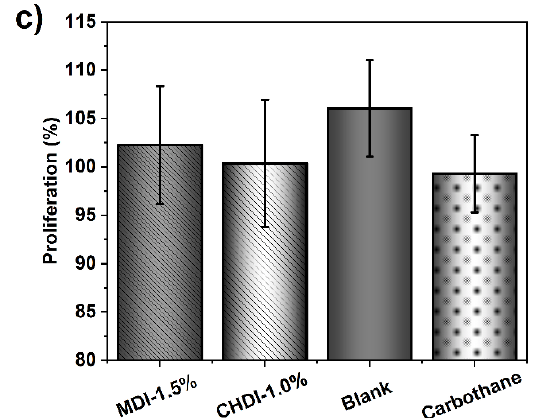
Figure 14. Viability of HaCaT cells after treatment with cell-medium extracts of PSU elastomers synthesized from ( a ) H 12 MDI, ( b ) IPDI, and ( c ) PSU copolymers synthesized from MDI and CHDI without chain extenders. The blank represents cell medium without a sample subjected to the same extraction conditions as the PSU samples. A medical-grade PU (Carbothane PS-3585A) was chosen as a reference material. Cell viabilities, as determined using the MTS cell proliferation assay, for all PSUs, PSU copolymers, and Carbothane are all over 95%. The error bars represent the standard deviation from 18 repeated measurements for each polymer-sample. Thus, no polymer extracts show any cytotoxic effects.